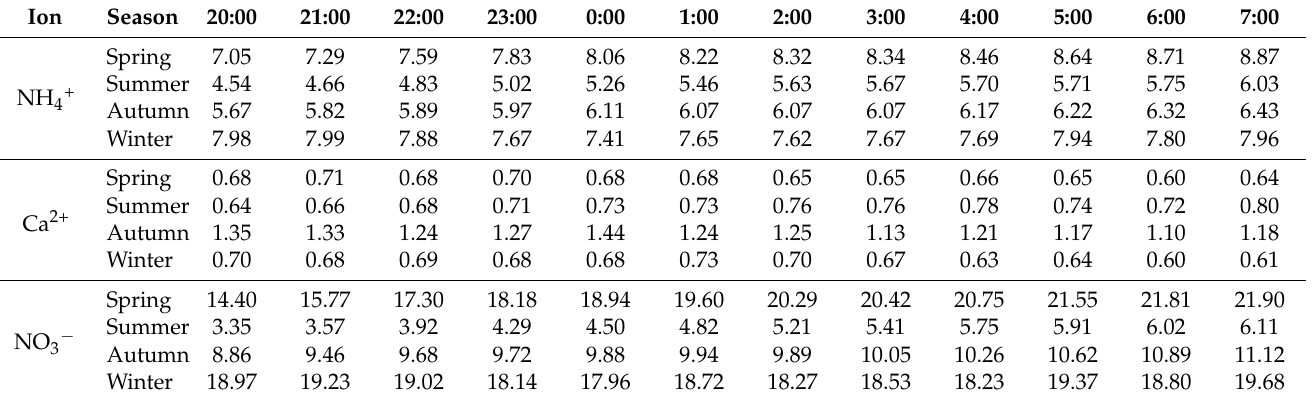
Table 2. Seasonal variation in night-time concentrations of different ions ( µ g/m 3